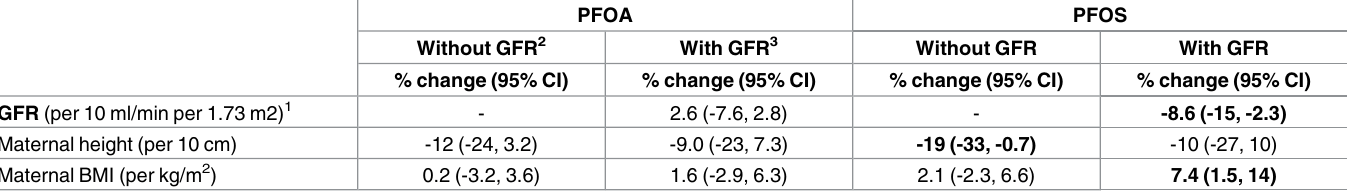
Table 5. Adjusted associations from multivariable regression models between GFR, maternal height and pre-pregnancy BMI, and ln-transformed maternal PFOA and PFOS levels in serum collected in 2 nd trimester from a subset of n = 88 mothers.